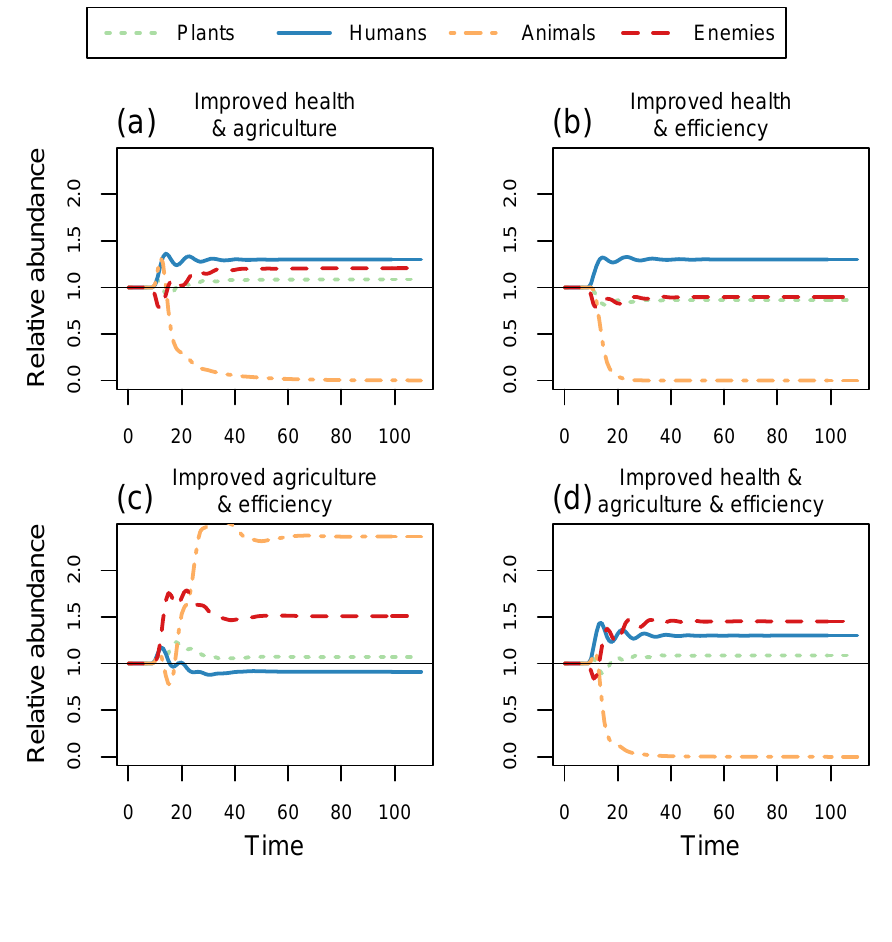
Figure A1.2. Effects of improvements in health, agriculture, and/or resource use efficiency on the abundances of humans, plant and animal resources, and shared natural enemies (e.g., zoonotic infections). As in Figure 2, except that the term c f AE was added to equation 4 and ae ae the term c AE was subtracted from equation 3. Here we assume that humans were superior at ae resisting the shared natural enemies ( c = 3 > c = ae he